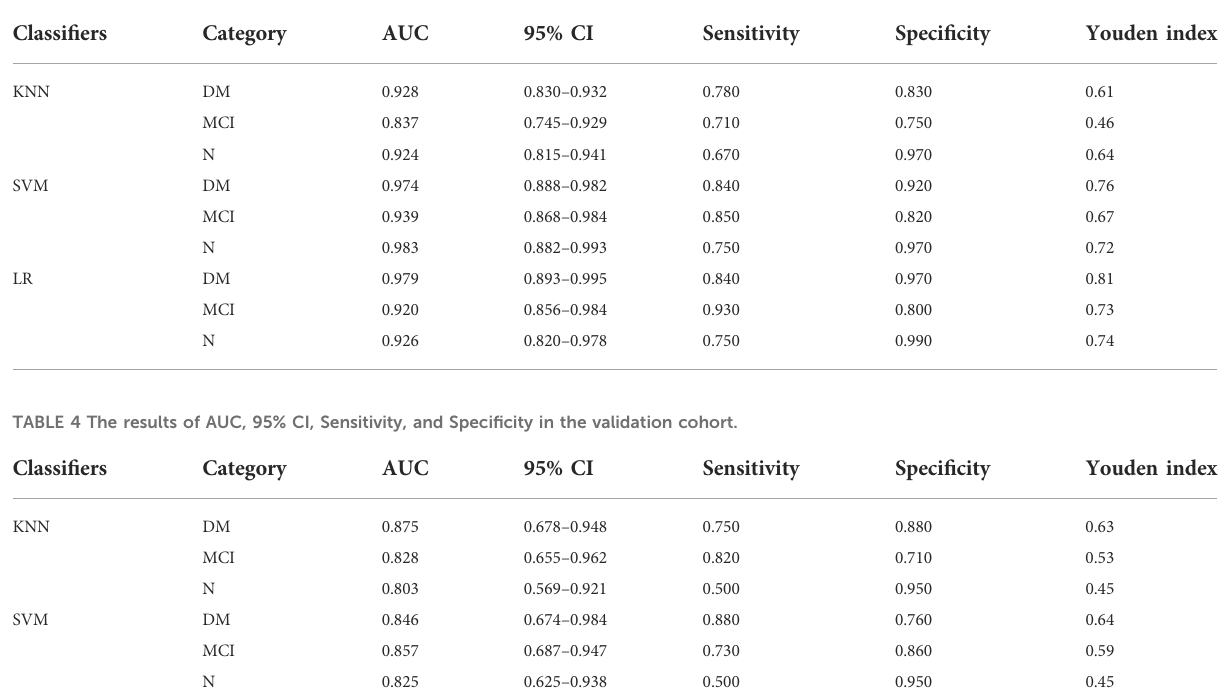
TABLE 3 ROC results with KNN, SVM, and LR classi fi ers of the training set.